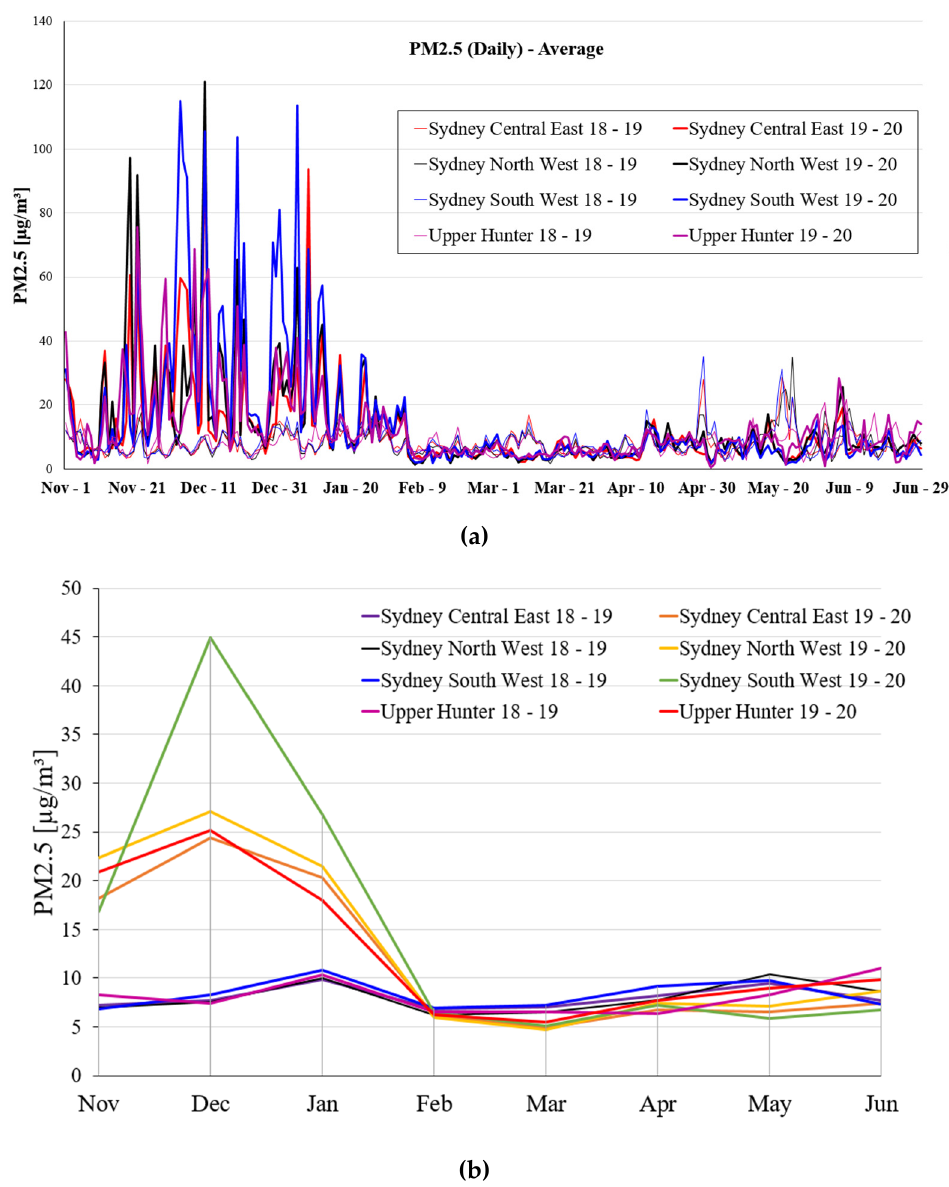
Figure 11. The average PM 2.5 emission in Sydney Central East, North West, South West and Upper Hunter region for a period of eight months during 2018–2019 and 2019–2020, ( a ) daily PM 2.5 emission, and ( b ) monthly PM 2.5